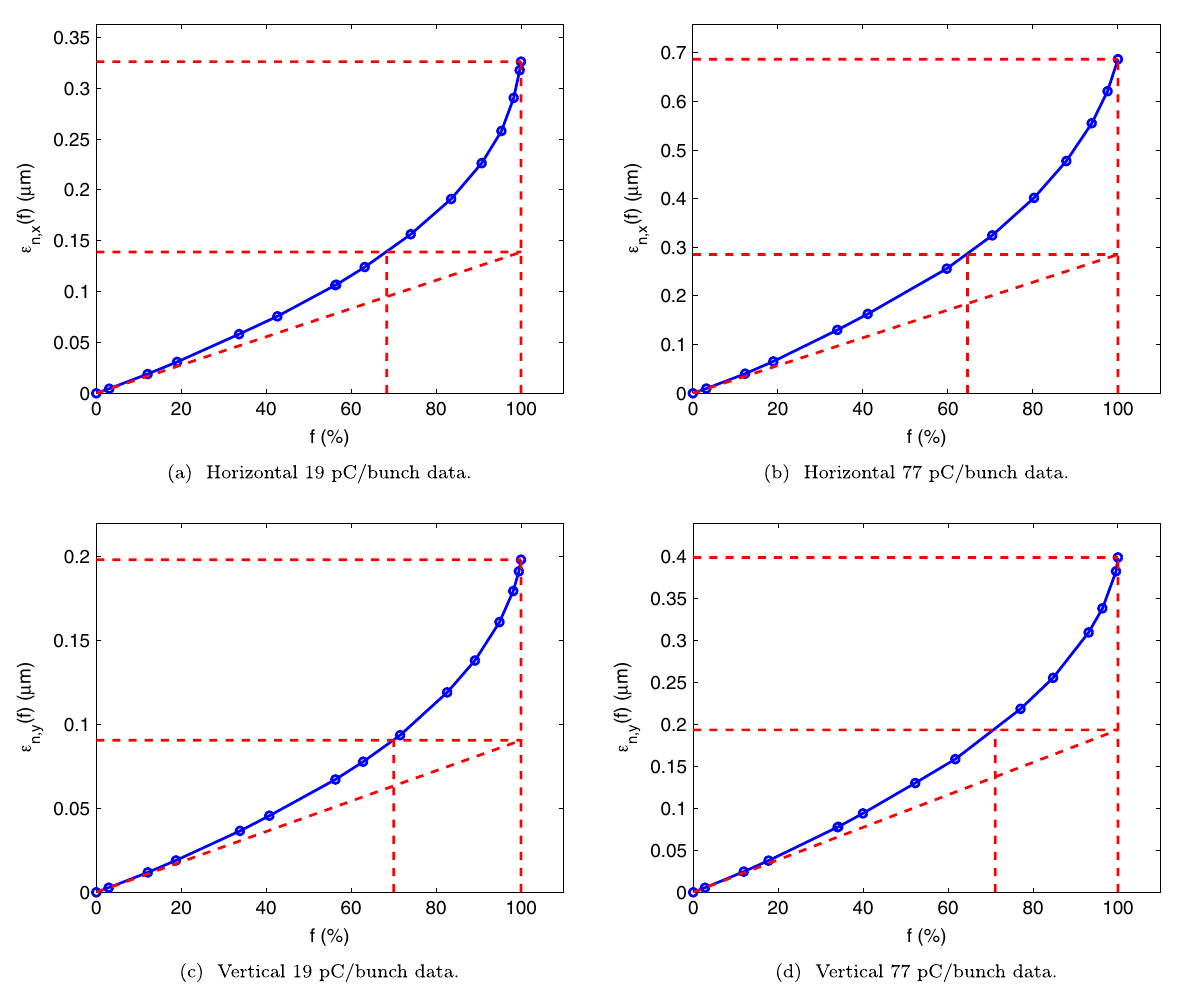
FIG. 14. Emittance versus fraction curves: (a) and (b) the curves computed from the measured horizontal phase-space data at 19 and 77 pC = bunch ; (c) and (d) the curves computed from the measured vertical phase-space data at 19 and 77 pC = bunch